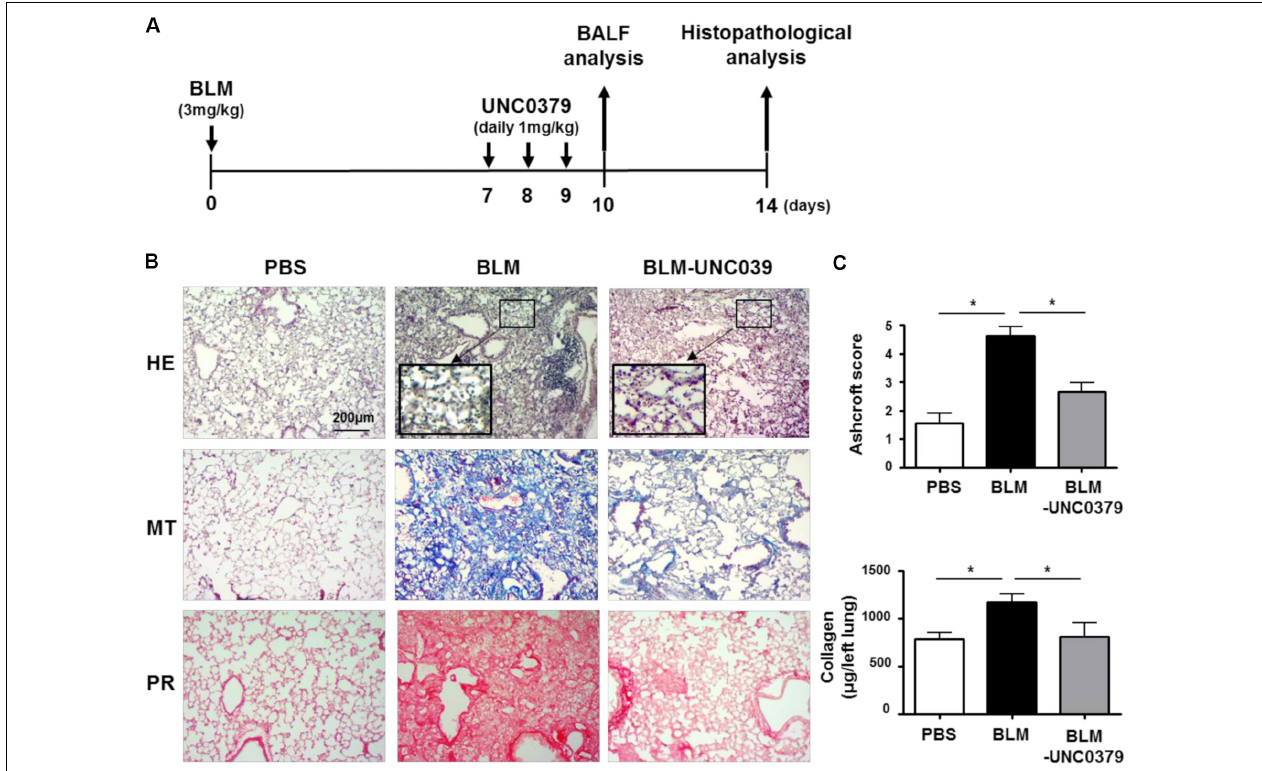
FIGURE 2 | UNC0379 attenuated BLM-induced lung fibrosis. (A) Timeline of drug administration and analysis. Mice were intratracheally administered PBS on days 0, 7, 8, and 9 (PBS group), BLM on day 0 and PBS on days 7, 8, and 9 (BLM group), and BLM on day 0 and UNC0379 (1 mg/kg) on days 7, 8, and 9 (BLM-UNC0379 group). The BAL fluids were recovered at 10 dpi. At 14 dpi, the left lungs were subjected to histopathological analyses. (B) Representative histological images of the lung sections stained by hematoxylin and eosin (HE), Masson’s trichrome (MT), and picrosirius red (PR) in each experimental group. (C) The fibrotic severity was evaluated using the Ashcroft score in 5 different lesions obtained from each experimental group. The collagen contents of the left lung lobes in each experimental group were measured and normalized to the weight of each left lung. Data are shown as the mean ± SEM ( n = 6). * p < 0.05 (measured by one-way ANOVA followed by Tukey’s